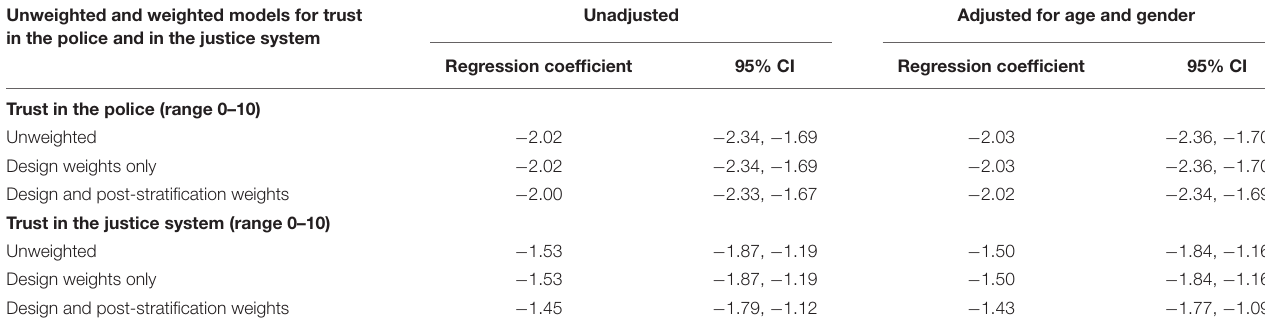
TABLE 1 | Differences in institutional trust between the (Scandinavian Star) sample and the general population data, in weighted and unweighted population data and in unadjusted and age and gender-adjusted models. Unweighted and weighted models for trust in the police and in the justice system